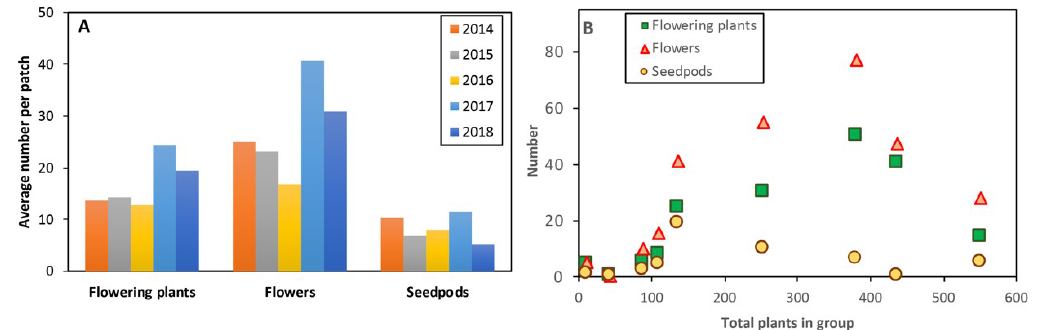
Figure 2. Observations of flowering and fruit set trends for Leporella fimbria ; ( A ) Flowering and pollination outcomes per group of plants; ( B ) Numbers of leaves, flowers and capsules relative to group size.